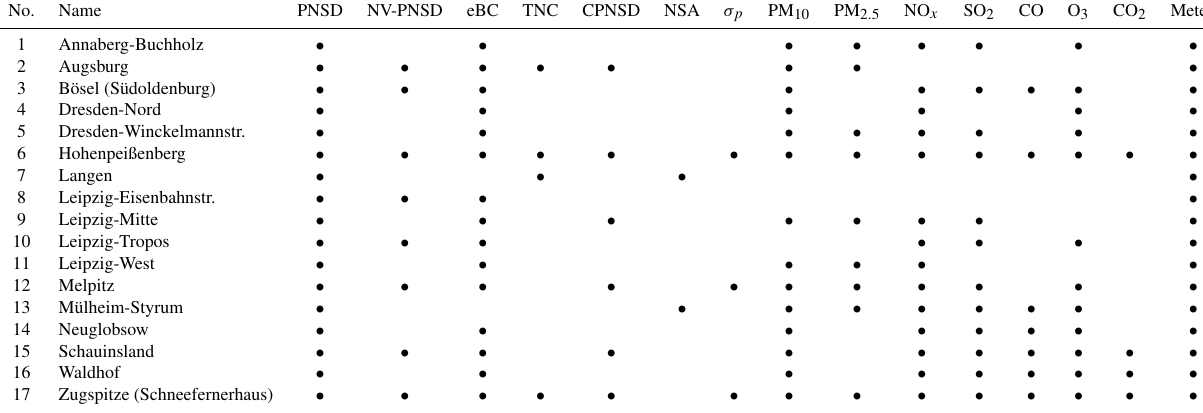
Table 3. Co-location of GUAN measurements with other continuous aerosol and air pollutant measurements. The core of GUAN measure- ments include sub-µm particle number size distributions (PNSD), sub-µm particle number size distributions of non-volatile particles (NV- PNSD), and equivalent black carbon mass concentrations (eBC). Additional continuous measurements may include total particle number concentration (TNC) – measured by condensation particle counters; coarse particle number size distribution CPNSD – using an aerodynamic particle sizer (APS) or an optical particle counter (OPC); nanoparticle surface area (NSA) – using an NSAM monitor; aerosol scattering coefficient ( σ p ) – using a nephelometer; PM x particle mass concentrations; and basic meteorological parameters (Meteo) including T , RH, wind speed, wind direction, global radiation, and precipitation. These additional data need to be obtained directly from the operator of the respective measurements.